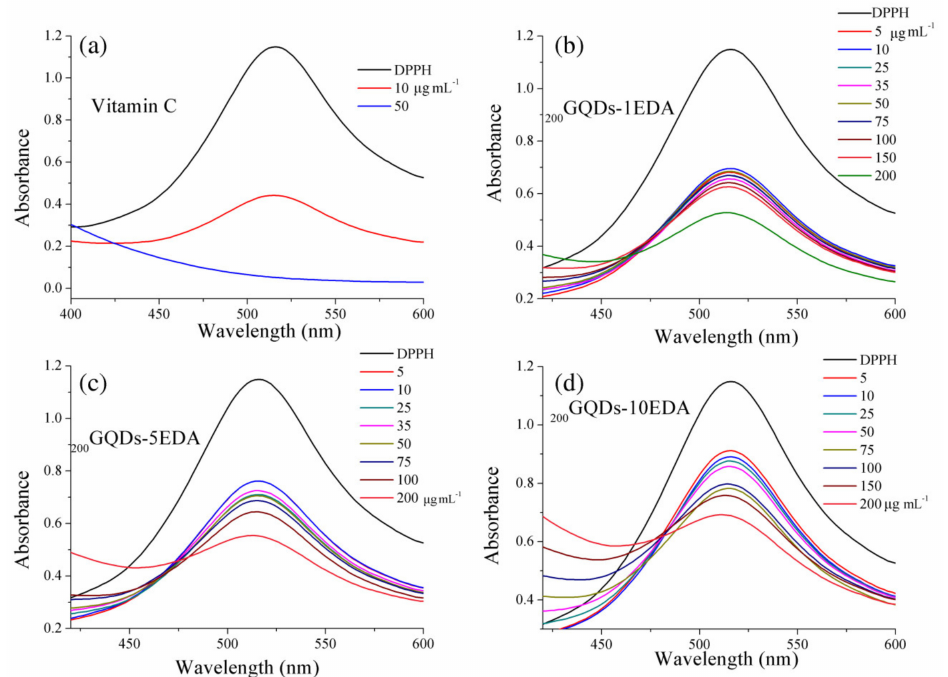
Figure 7. DPPH • -scavenging assay: UV/Vis absorption spectra of 100 µ M DPPH • methanol solution with vitamin C at 10 and 50 µ g · mL − 1 ( a ), and with GQDs samples 200 GQDs-1EDA ( b ), 200 GQDs- 5EDA ( c ), and 200 GQDs-10EDA ( d ), at concentration values ranging from 5 to 200 µ g · mL − 1 after 1 h in